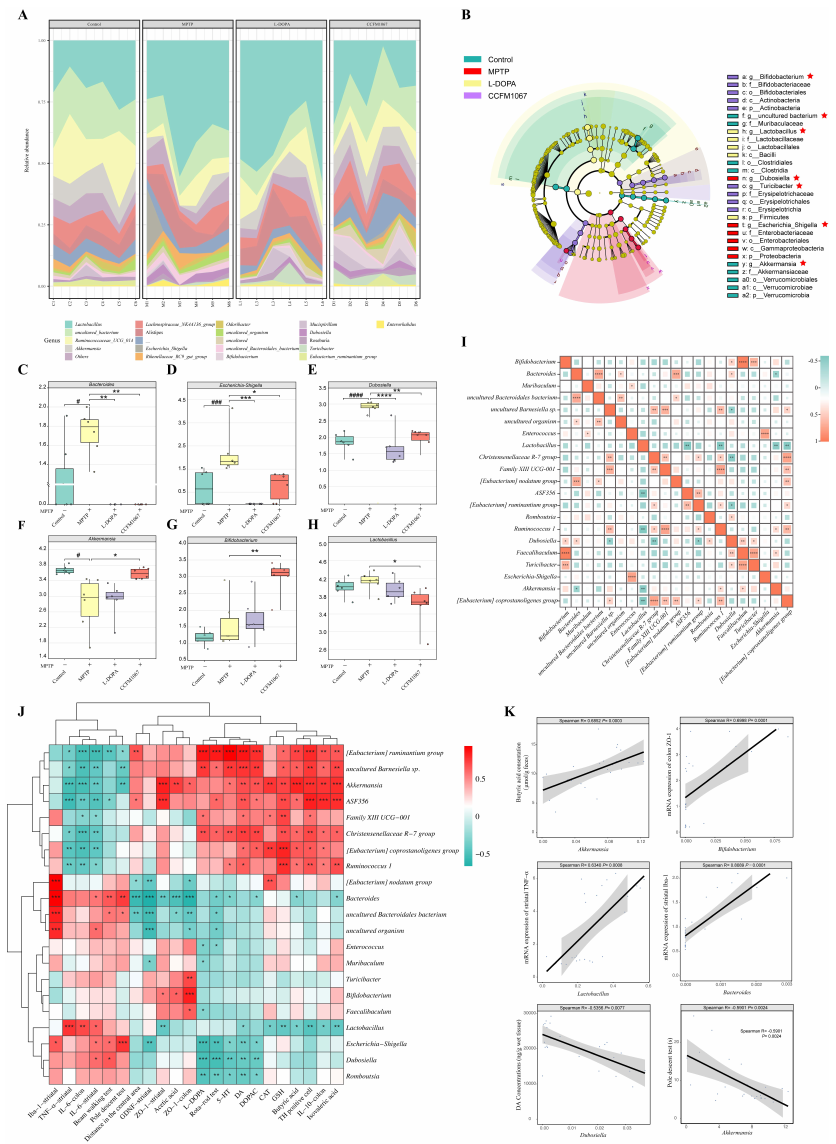
Figure 5. B. breve CCFM1067 intervenes to regulate MPTP − induced changes in the gut microbial composition of PD mice. ( A ) Stacked bar plots representing the relative abundance of genera in individual samples from the four different groups. ( B ) LEfSe analysis of the control, MPTP, L − DOPA, and B. breve CCFM1067 groups. Species without significant differences are colored uniformly in yellow, and the differential species biomarker follows group coloration. The figure shows the species with significant differences in abundance between groups at p < 0.05 and log LDA > 4.0. ( C – H ) Six genus levels are shown in the figure, namely Bacteroides ( C ), Escherichia − Shigella ( D ), Dubosiella ( E ), Akkermansia ( F ), Bifidobacterium ( G ) and Lactobacillus ( H ). The data in the figure are normalized by log 10 . ( I ) Correlation analysis of the total significantly different 21 genera between the four groups. The color and size of the square represent the degree of correlation determined using two- tailed Spearman’s analysis. ( G ) Spearman’s correlation analysis between 22 other exper- imentally determined PD biomarkers and the 21 different genera. Red indicates positive correlation, green negative, and color intensity indicates the strength of the correlation. ( K ) Positive correlation between fecal Akkermansia abundance and the level of butyric acid in mouse feces; positive correla- tion between fecal Bifidobacterium abundance and the mRNA expression of ZO-1 in the colon of mice; positive correlation between fecal Lactobacillus abundance and the mRNA expression of TNF- α in the midbrain of mice; positive correlation between fecal Bacteroides abundance and the mRNA expression of Iba-1 in the mouse striatum; the amount of DA in the mouse striatum was inversely proportional to the amount of Dubosiella in the feces; the abundance of fecal Akkermansia was